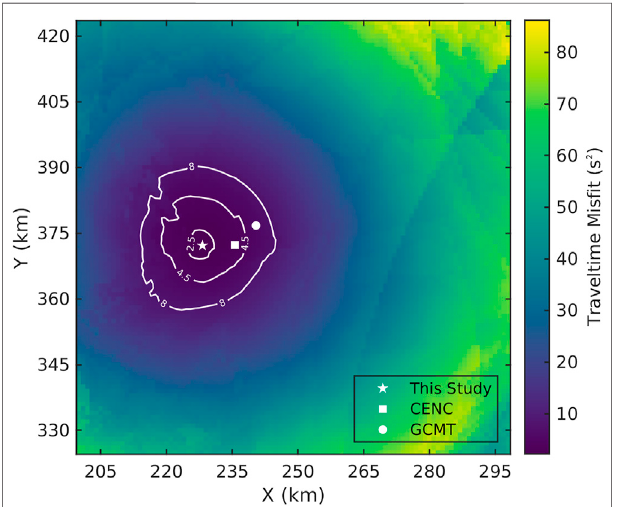
FIGURE 6 | The traveltime mis fi t map along with three contours (white lines), the centroid location in this study (white star), epicenter location by CENC (white square) and centroid location by Global CMT (white dot) at the event depth (3.14 km).